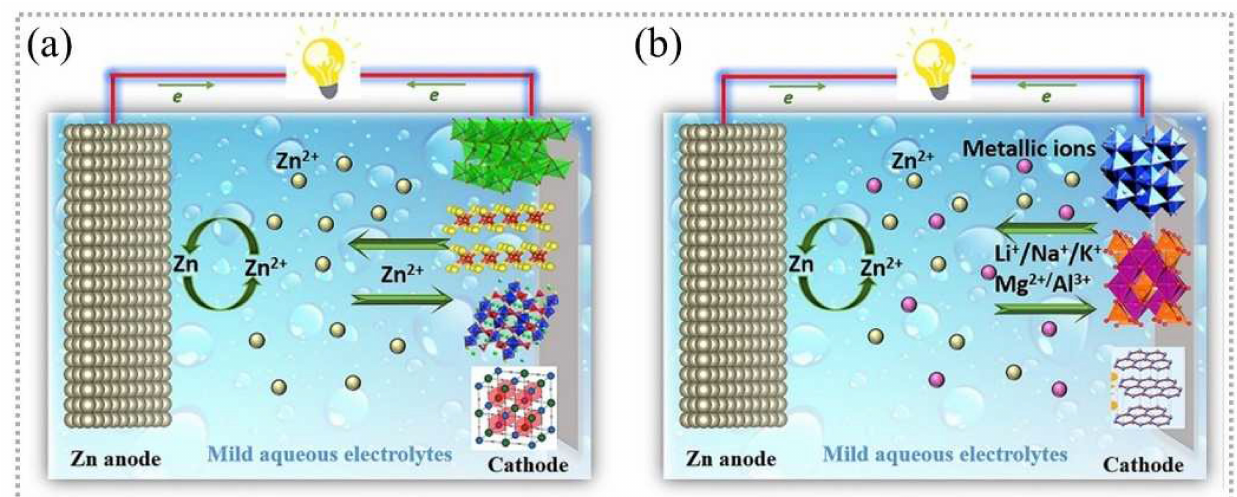
Figure 2. Schematic illustrations of the principles of ( a ) aqueous Zn-ion batteries (AZIBs) and ( b ) aqueous Zn hybrid batteries (AZHBs). Adapted with permission from Ref. [34]. Copyright 2019, Energy Storage